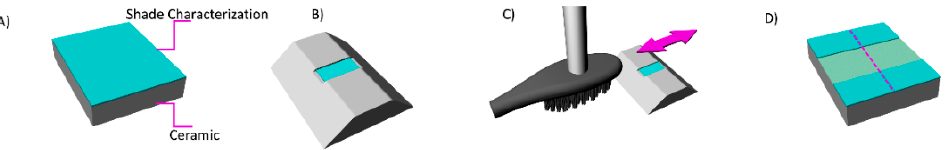
Figure 2. Schematic illustration of toothbrushing simulation. ( A ) Extrinsically stained ceramic specimen. ( B ) Metallic device positioned to restrict the brushing area. ( C ) Brushing direction during the test. ( D ) Inspection path of the wear profile of brushed specimen.